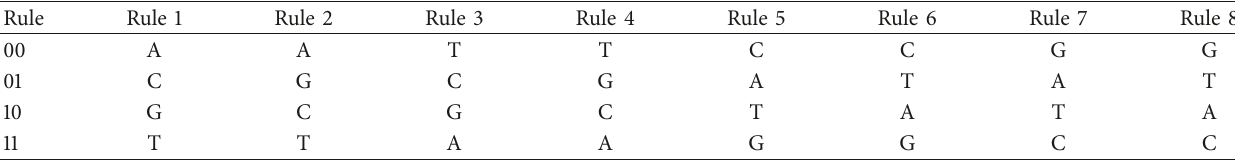
Table 1: Encoding and decoding rules of DNA.